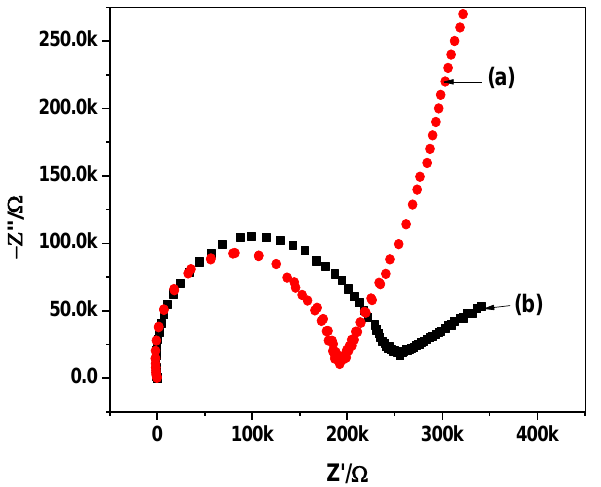
Figure 6. Impedance spectra for (a) C/harmine-ISE and (b)